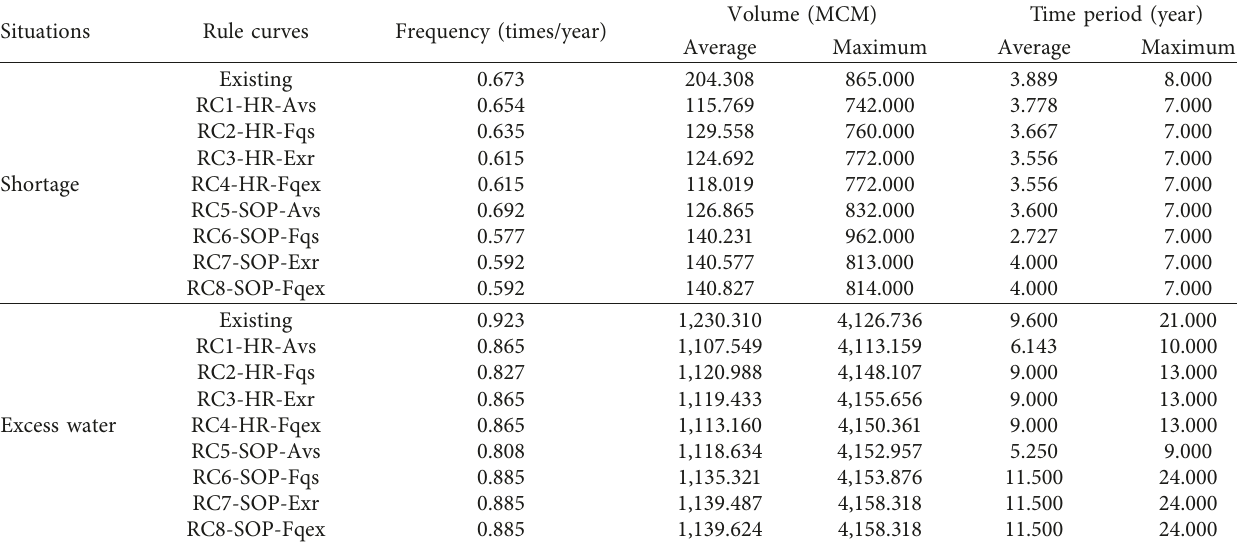
Table 2: The situations of water shortage and excess water considering historic inflow 52 years using HR criteria.